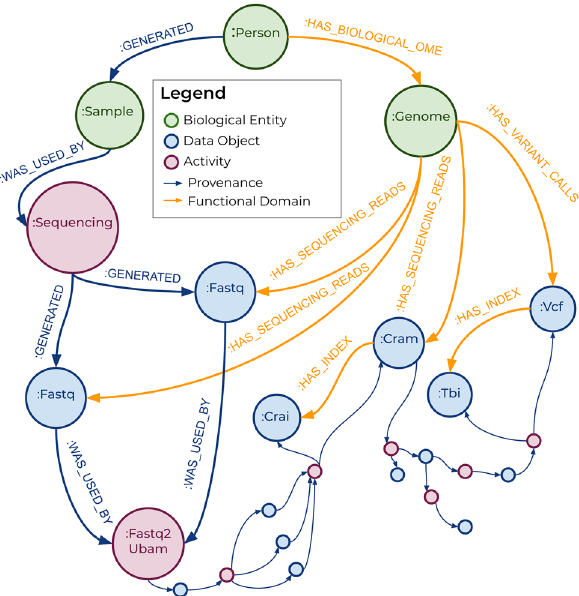
Figure 2. The graph database model includes different types of nodes that are connected by two categories of relationships: provenance domain and functional domain. These relationships allow for querying of data that is related via lineage or functional